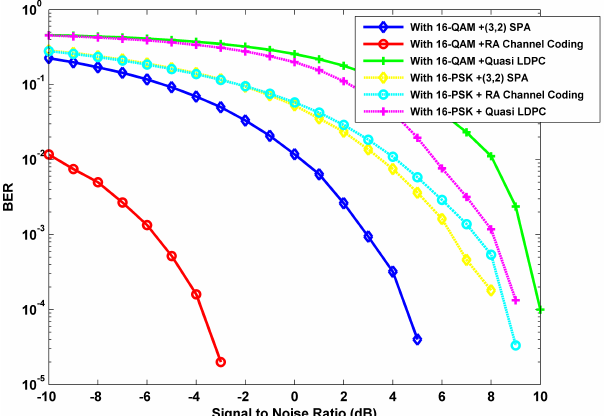
Figure 7. BER performance of the considered system with utilization of various channel coding, higher − order digital modulation, and ZF signal detection techniques for user